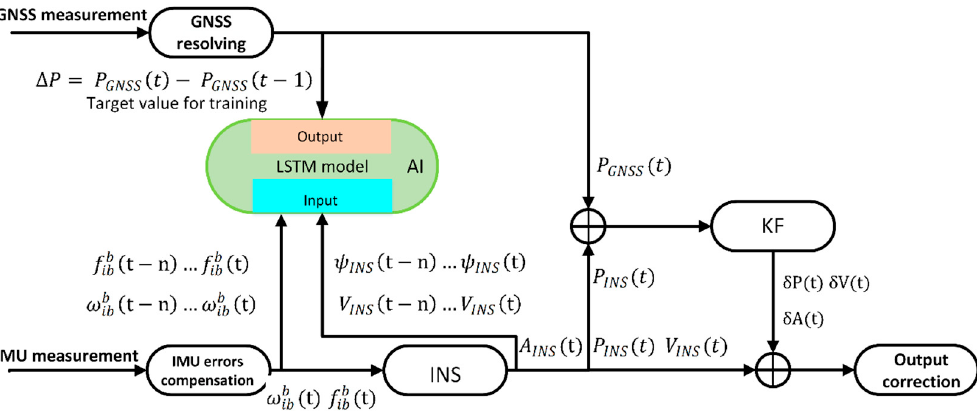
Figure 4. Block of the training.